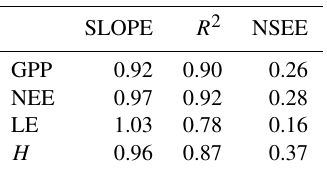
Table 4. Validation of the multilayer model CANVEG using eddy covariance measurements of gross primary productivity (GPP), net ecosystem exchange (NEE), and latent and sensible heat flux (LE and H ). Slopes, R 2 values and normalized standard error estimates (NSEE) of linear regressions between modeled and measured val- ues are comparable to the numbers given by Knohl and Baldocchi (2008).